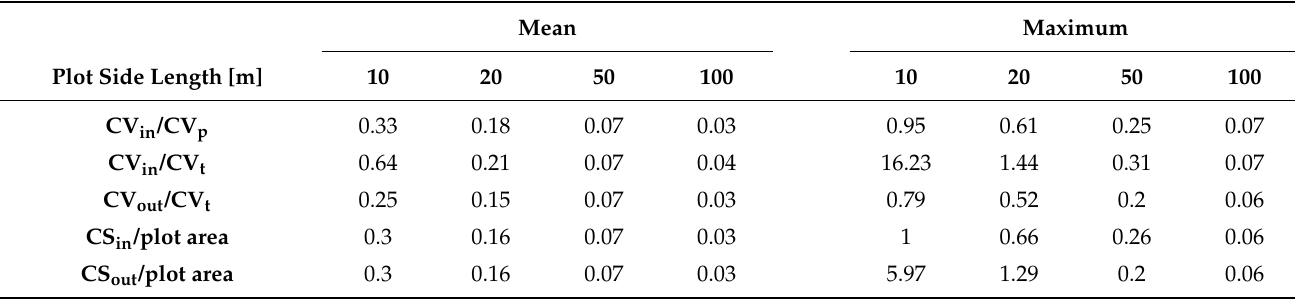
Table 1. Proportions of the crown volume (CV) and visible canopy surface (CS) for different plot sizes. The values represent the means and maxima observed in the 50-ha investigation